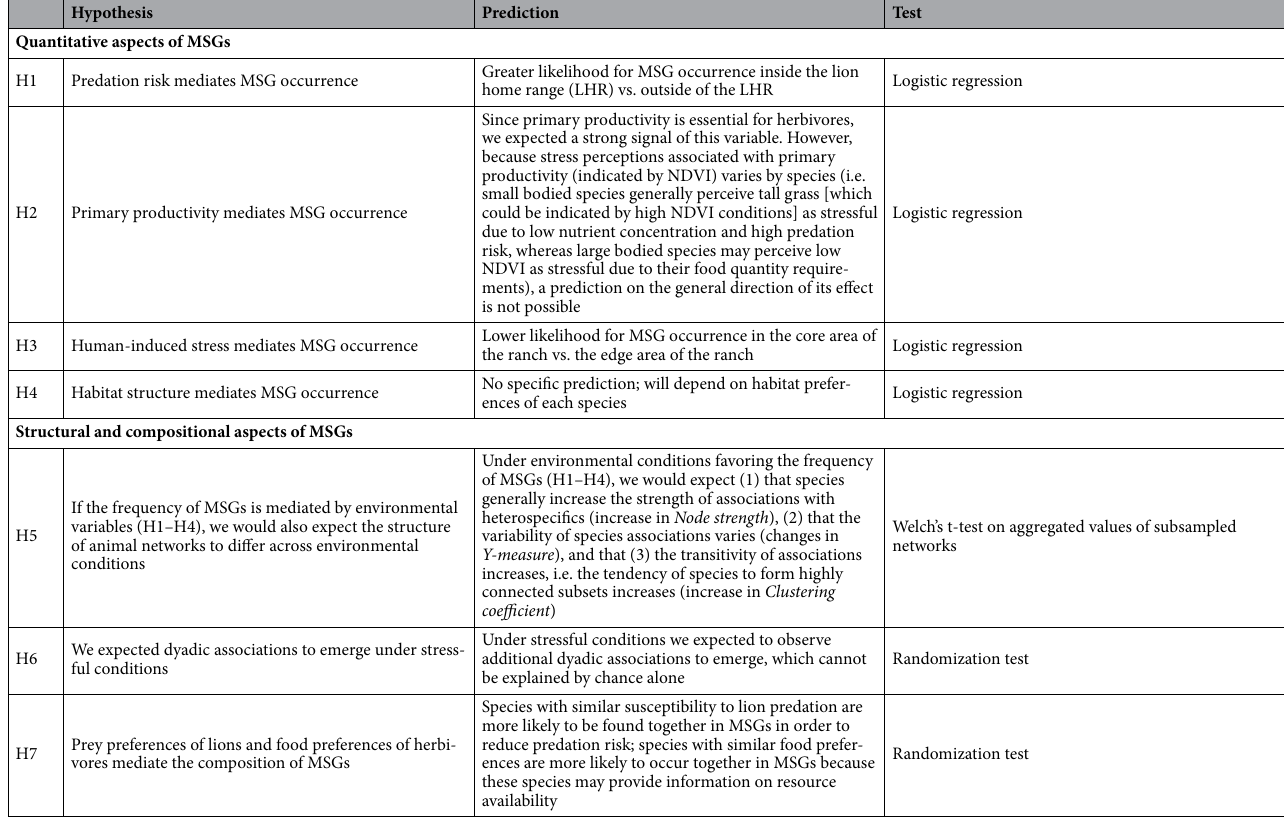
Table 2. Testing the stress gradient hypothesis for mixed species groups (MSG) of African savanna herbivores. For each specific hypothesis, we outlined predictions and indicated the type of test (see “Methods” section for more